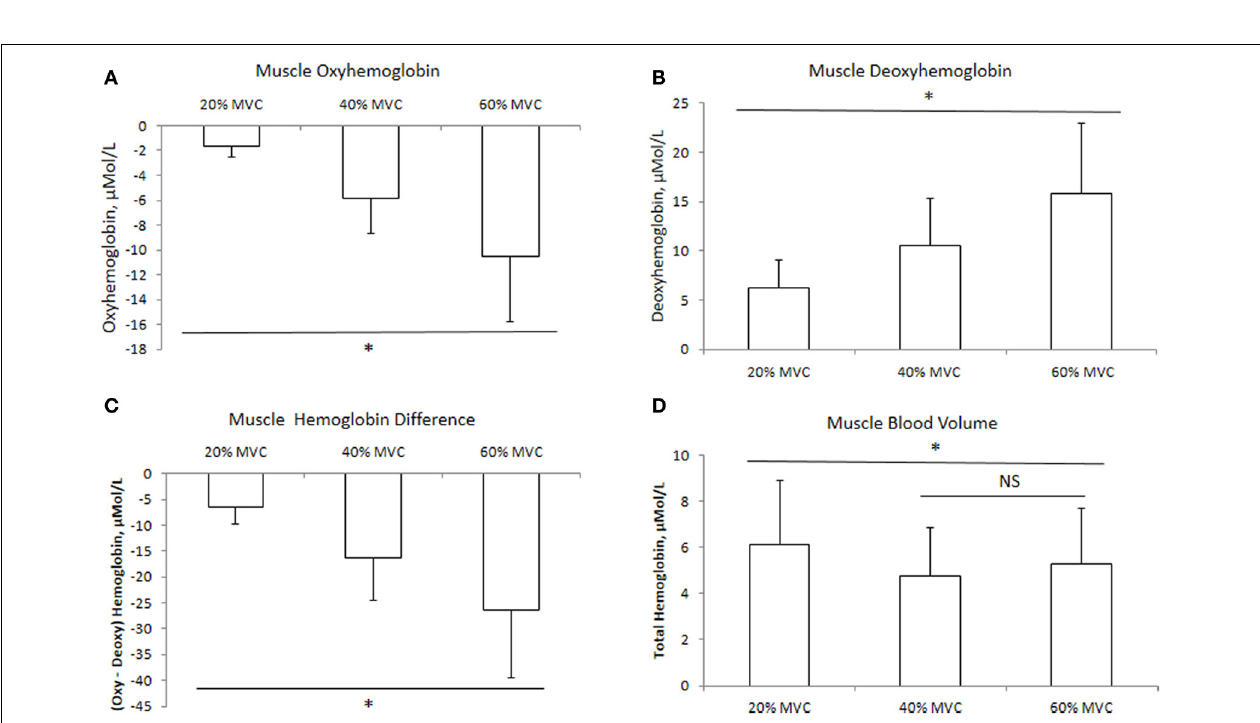
FIGURE 1 | Cerebral hemodynamic responses at three different intensities of intermittent isometric contractions of the biceps brachii. ∗ Indicates P < 0 . 05.